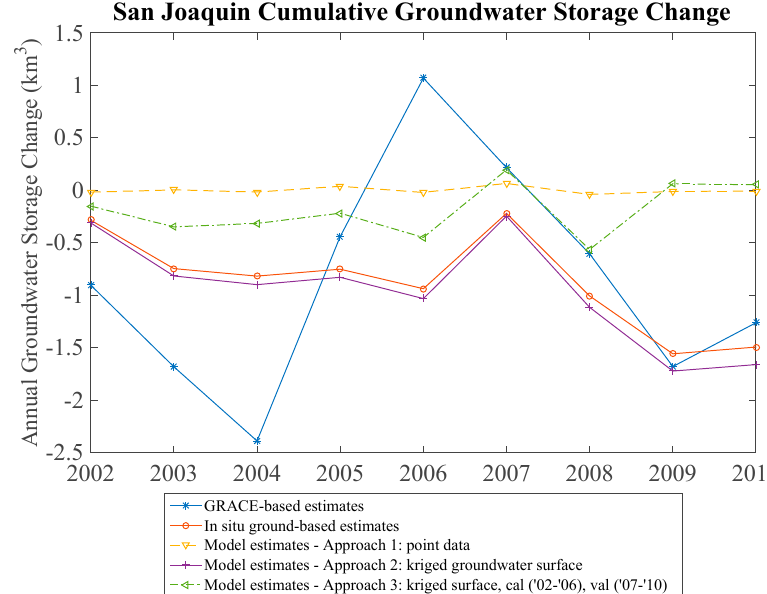
Figure 7. Cumulative annual groundwater storage change (km 3 ) for the San Joaquin groundwater basin, as estimated by GRACE water storage changes (blue), by ground-based in situ groundwater data (red), and by the three downscaling models (yellow, purple, green).